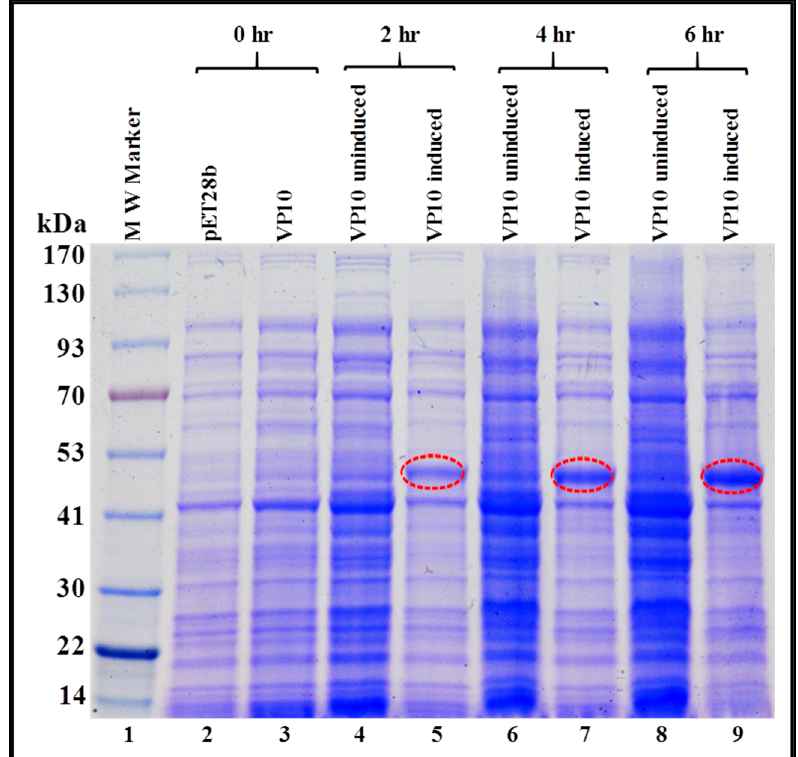
Figure 4. Expression of a recombinant FIV full-length Pr50 Gag -His 6 -tag fusion protein in Escherichia coli ( E. coli ) lysates. BL21(DE3) cells transformed with VP10 were grown overnight at 37 °C, and then induced with IPTG and further cultured for varying time points at 37 °C. Total bacterial cell lysates were prepared from uninduced and IPTG-induced cultures and analyzed by SDS-PAGE. Coomassie Brilliant Blue-stained SDS-PAGE confirms that full length Pr50 Gag -His 6 -tag fusion protein is expressed efficiently from VP10.